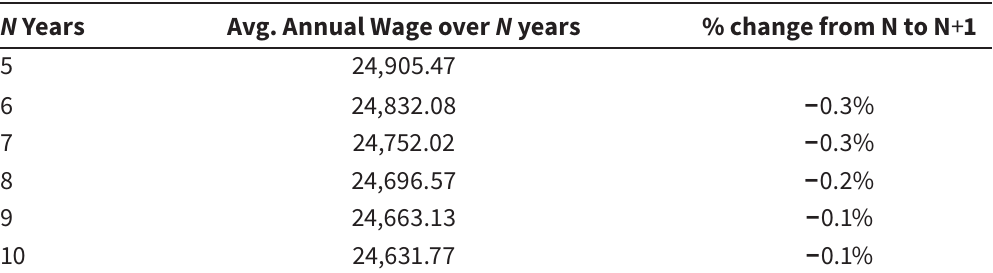
Change in the pension base (average of last N years of wages before pension claiming)